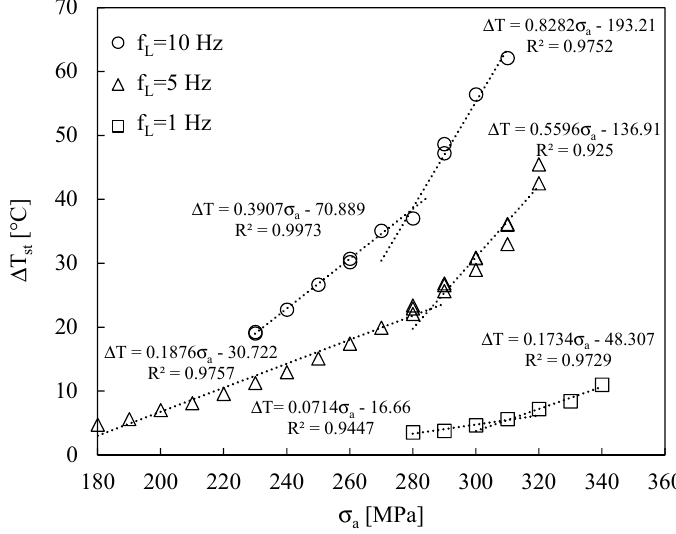
Figure 14. Risitano method [5] applied to AISI 304L cold-drawn bars.